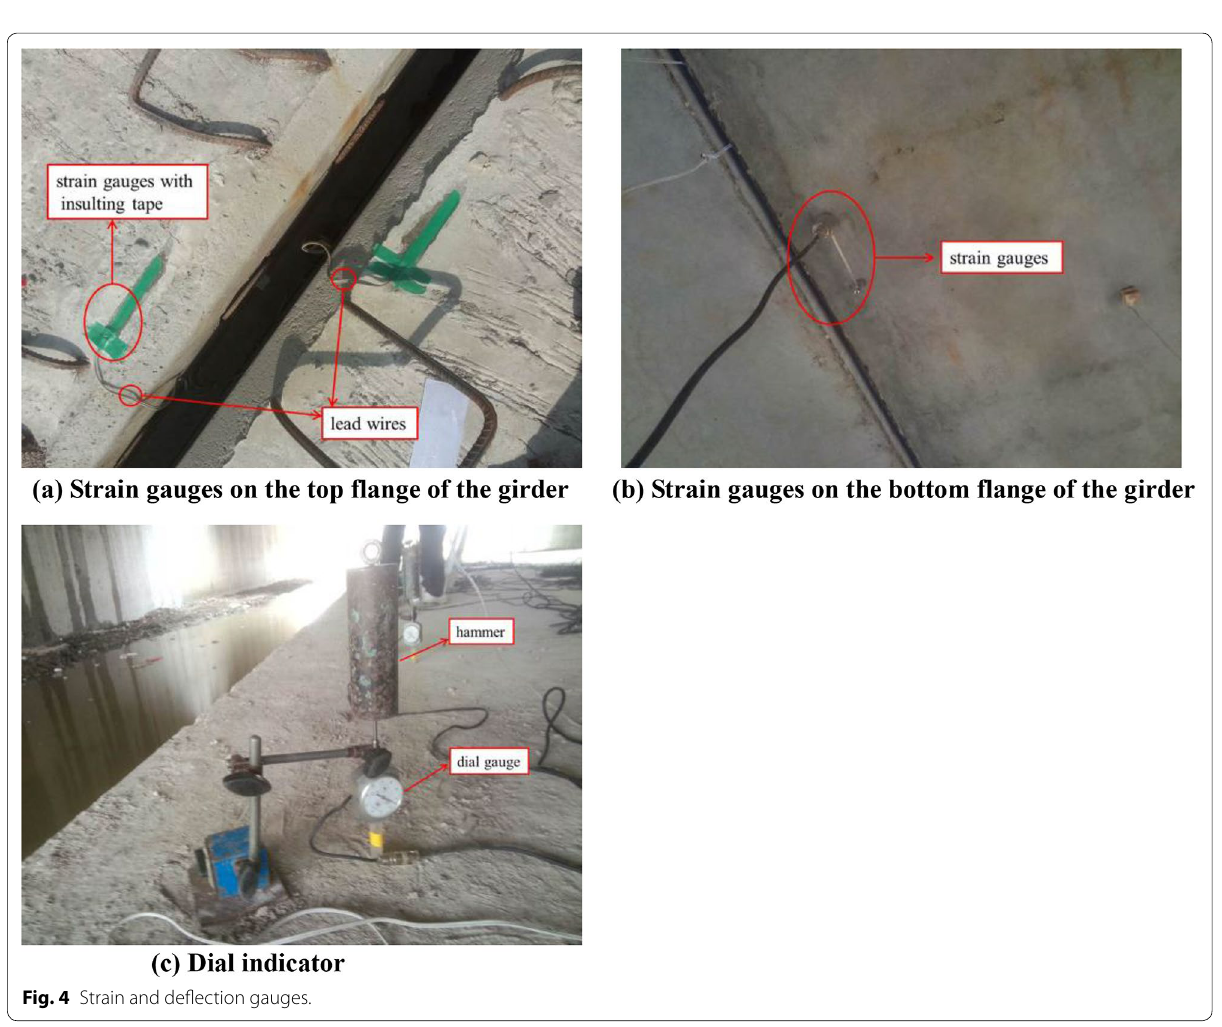
Fig. 4 Strain and deflection gauges.